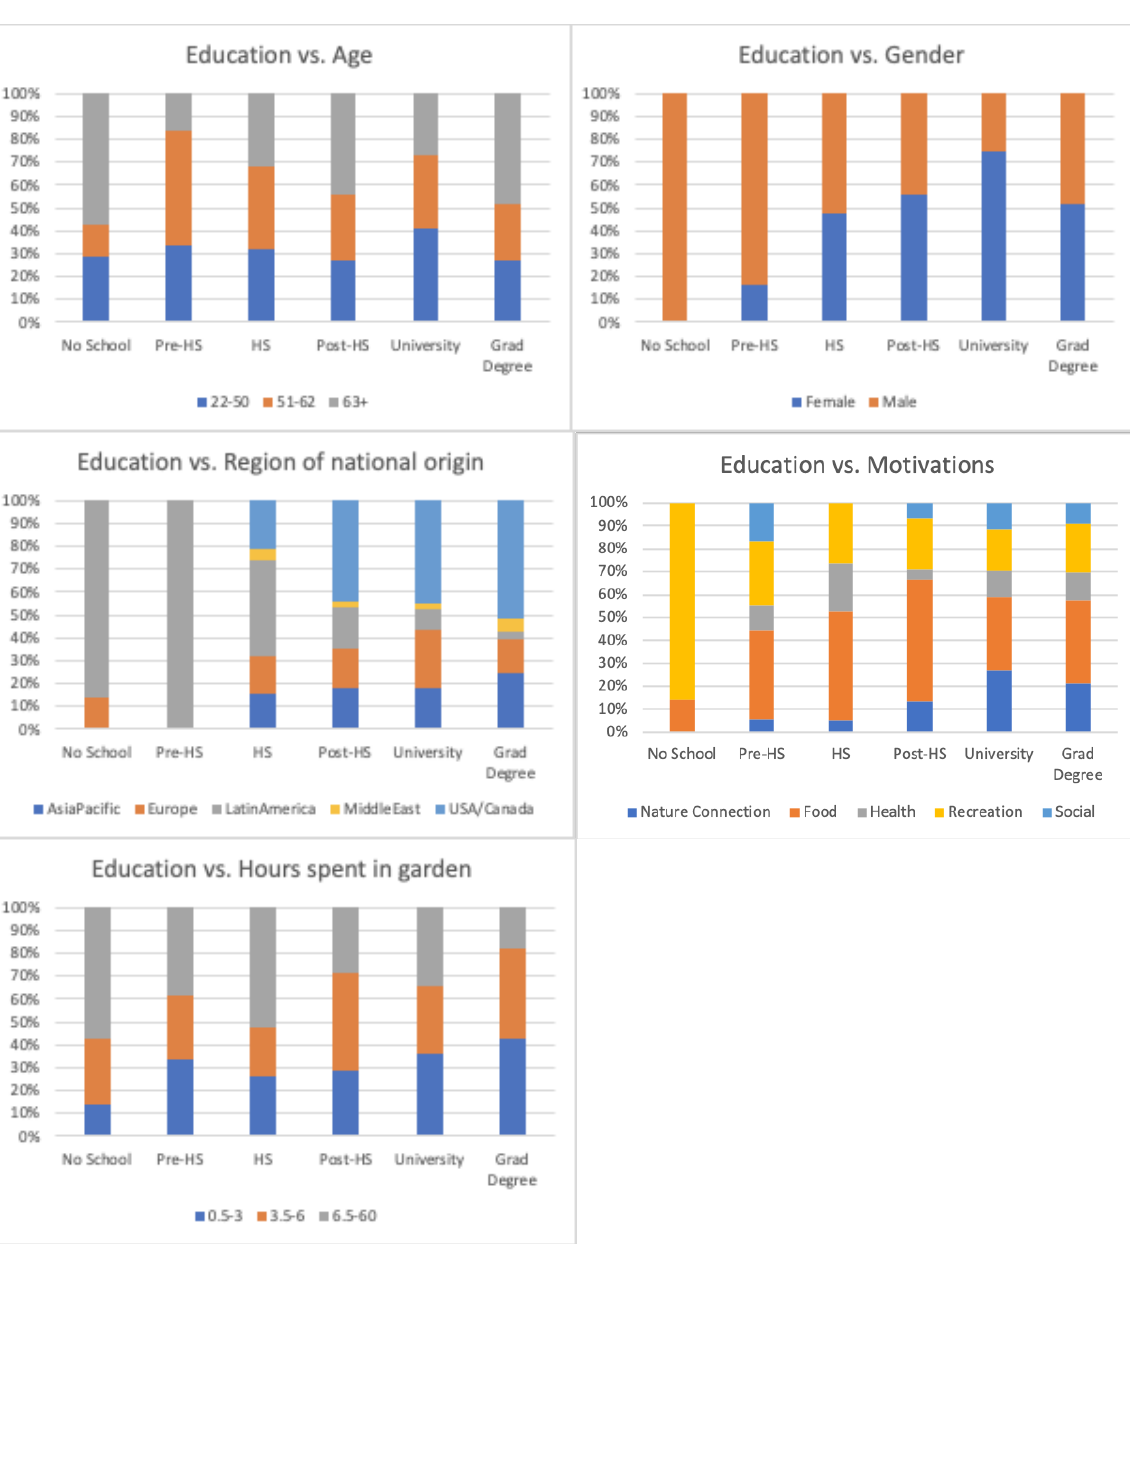
Figure A2.3. Relationships between education, age, gender, region of national origin, motivations for gardening, and hours spent